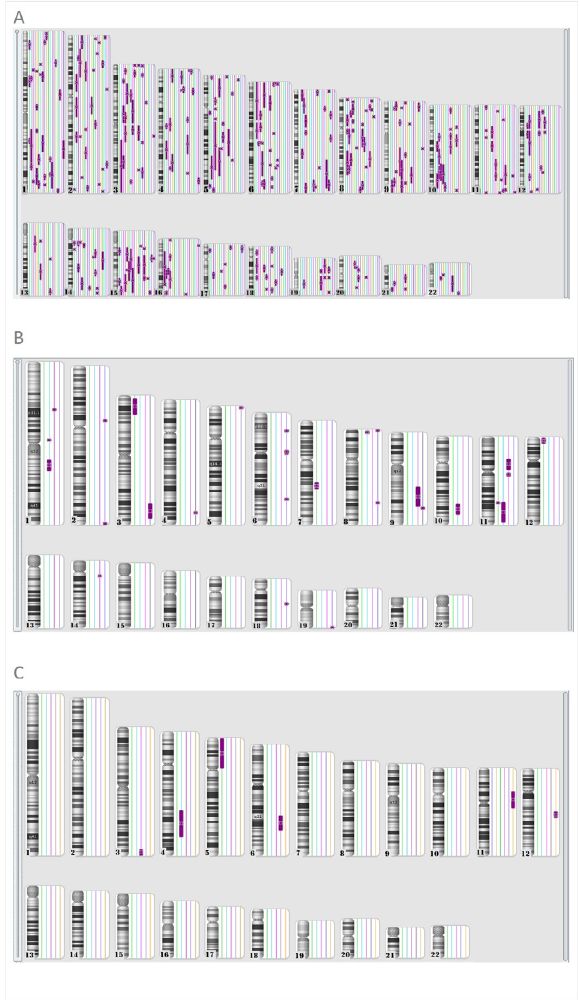
Figure 2 – Karyoview from Affymetrix® Chromosome Analysis Suite (ChAS) Software demonstrating: (A) all multiple ROH exceeding 1% of the autosomal genome of the 19 patients; (B) all multiple ROH exceeding 1% of the autosomal genome of the control group; and (C) ROH ≥10Mb in a single chromosome, in patients (chromosomes 3, 4, 5, 6 and 12) and controls (chromosome